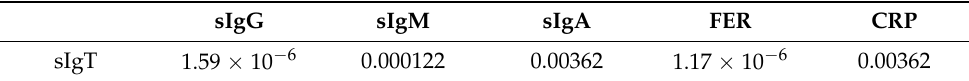
Table 1. p -values obtained for the model of the simple linear regression model. p -values lower than the statistically significant level of ( α = 0.05) can be considered to be related to sIgT.